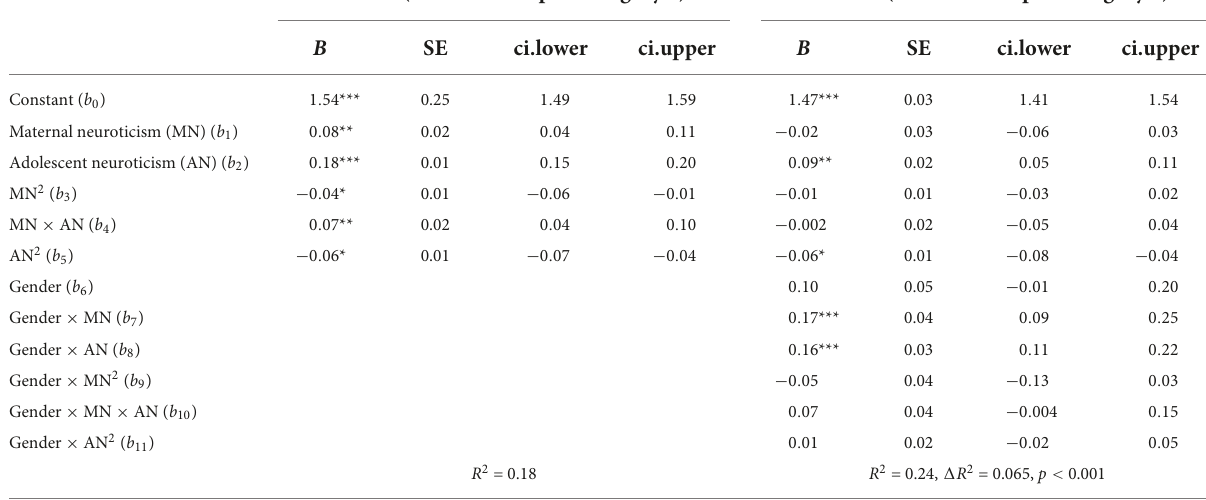
TABLE 4 Moderated polynomial regression